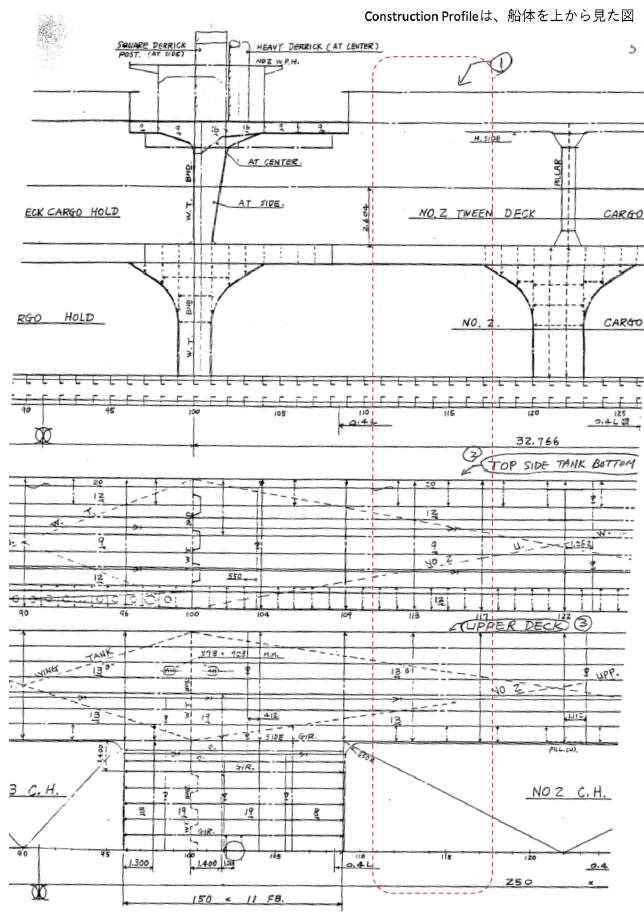
Figure 8. The Construction Profile